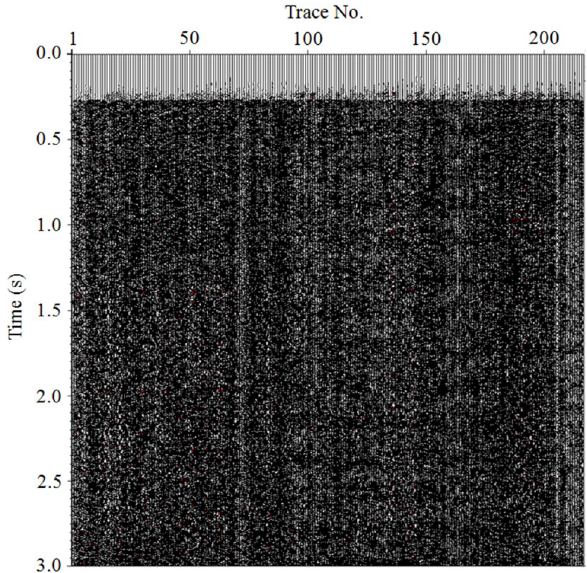
Fig. 16 Reflection signals separated from Fig. 14 using curvelet domain filtering. The curvelet domain filtering succeeds in suppress- ing background noise, but it did less well in terms of protection of coherent signals